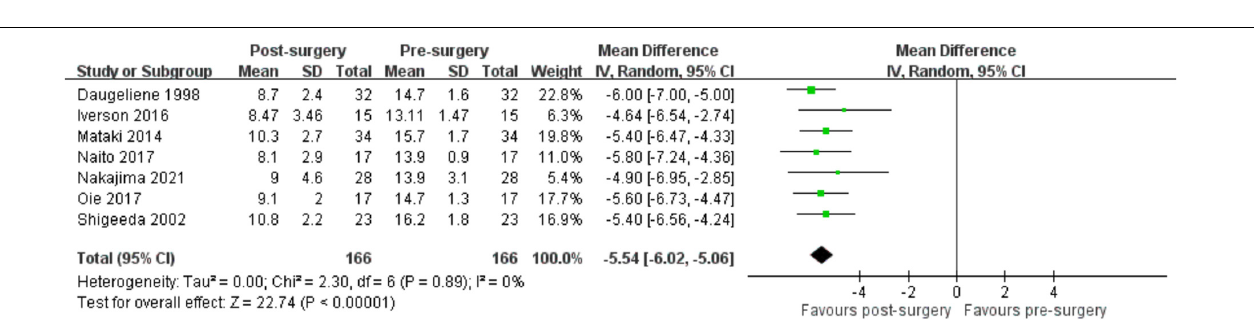
FIGURE 3 | Subgroup analysis: VF progression with MD slope in patients with NTG after trabeculectomy, stratified by baseline MD group.